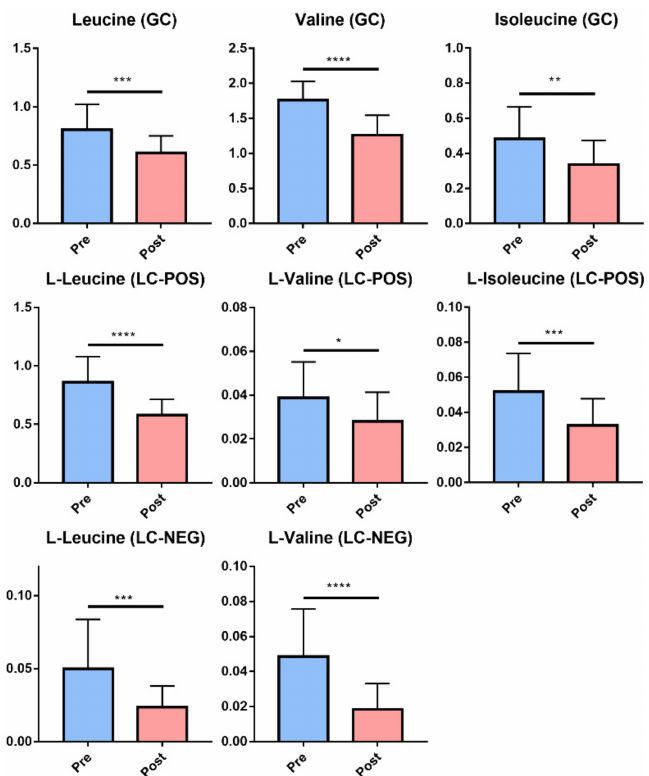
Figure 3. Changes of Branched Chain Amino Acids (BCAA) after metabolic surgery. The changes of BCAA (Leucine, Valine, and Isoleucine) in GC-MS (upper panel) and LC-MS (LC-POS, LC-MS positive ion mode, middle panel; LC-NEG, LC-MS negative ion mode, bottom panel) untargeted metabolomics analysis after metabolic surgery were shown. Data were presented as the mean ± SD. *, p < 0.05; **, p < 0.01; ***, p < 0.001; ****, p < 0.0001 (unpaired Student’s t